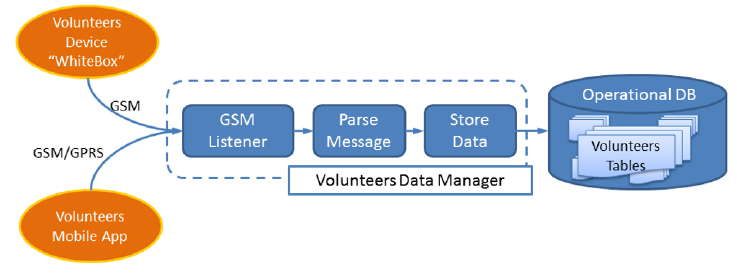
Figure 3. The service unit in the Marine Information System (MIS) dedicated to the management of Volunteered Geographical Information. The service unit takes care of storing received data in the operational database of the